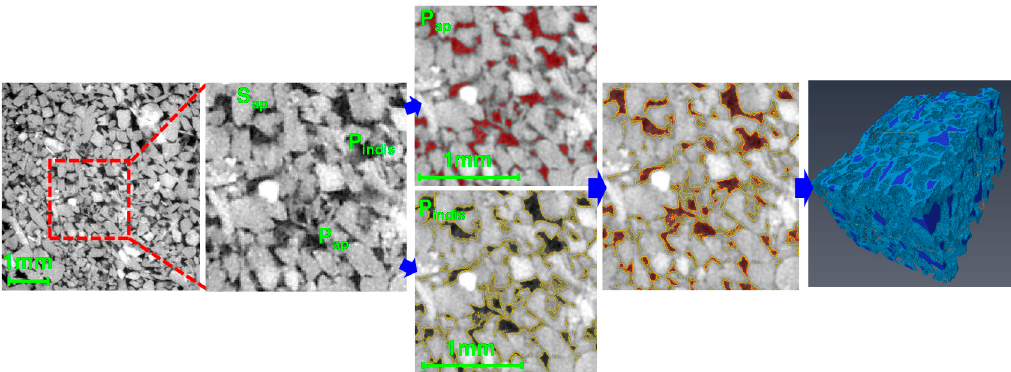
Figure 3. 2D segmented section images for designation of apparent pores, indistinct pores and solid phase. Based on the proposed method, the voxels of each phase were accurately detected and a 3D domain containing each designated phase was finally obtained (in case of Boise sandstone). Table 2. Intensity values of the ternary segmentation and pore geometry data derived from image processing for characterization of apparent and indistinct pores.